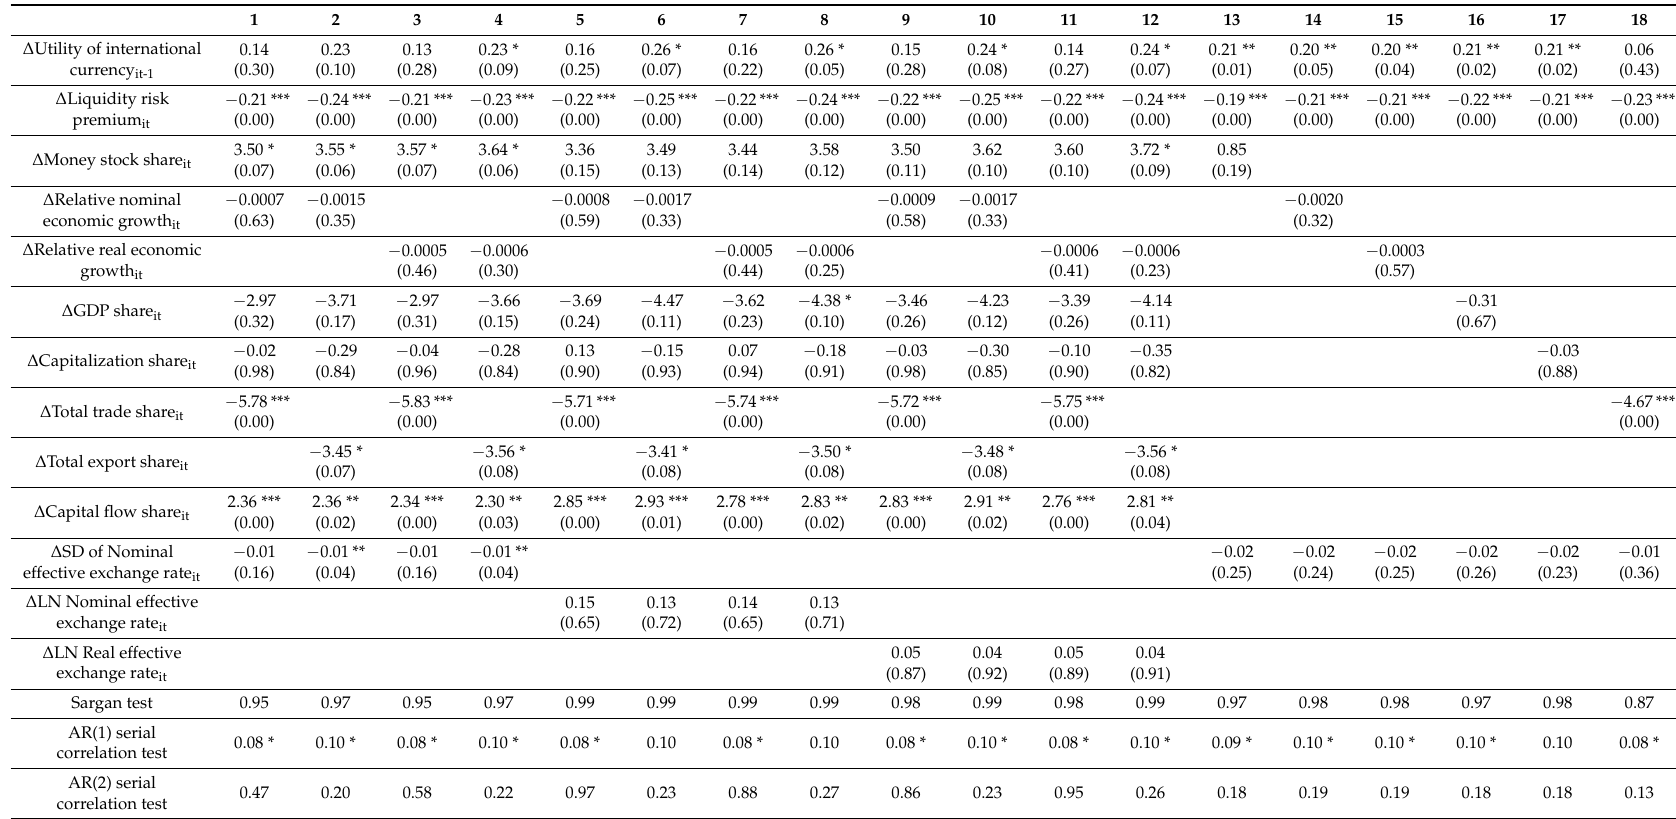
Table 2. Determinants utility of international currency (real interest rate